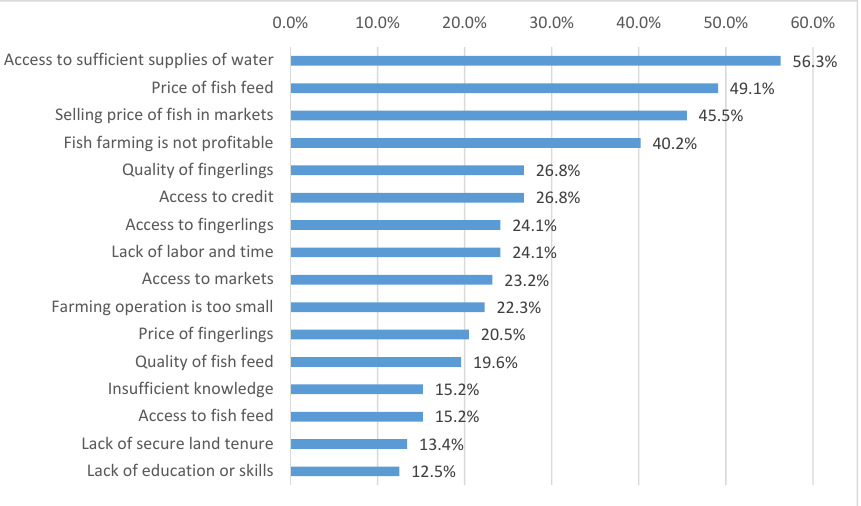
Figure 3. Reasons for discontinuing the practice of small-scale aquaculture ( n = 112).